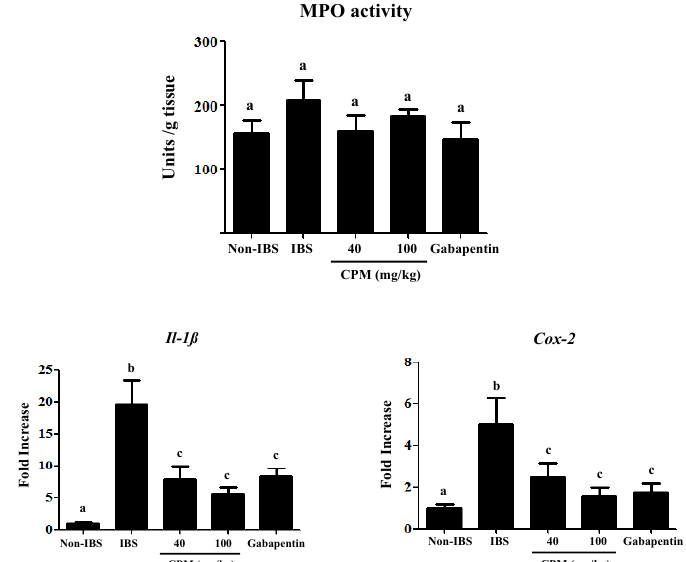
Figure 3. Effects of CPM (40 mg/kg and 100 mg/kg) and gabapentin (70 mg/kg) on colonic myelopereoxidase (MPO) activity and gene expression of Il-1 β and Cox-2 in rats two weeks after DCA administration. Data are expressed as means ± SEM ( n = 8). Groups with different letters differ statistically ( p < 0.05).